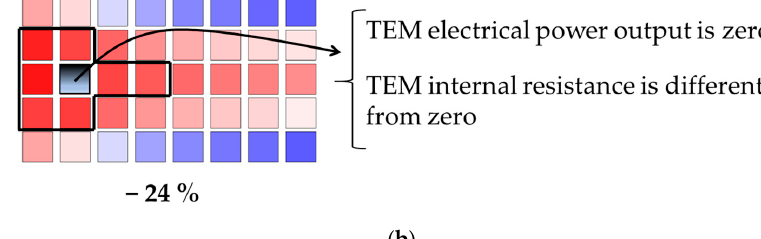
Figure 12. Connection configurations of different groups of TEMs.